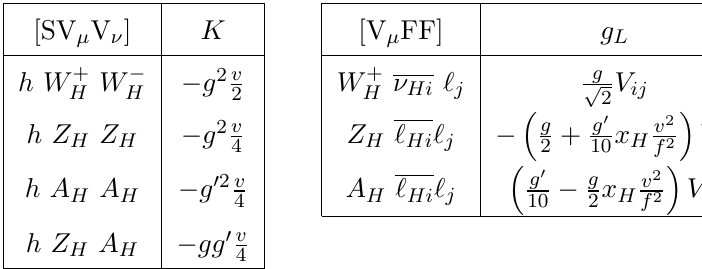
Table 3 . Scalar-Vector-Vector and Vector-Fermion-Fermion couplings at O ( v 2 =f 2 ). The right- handed Vector-Fermion-Fermion couplings g R